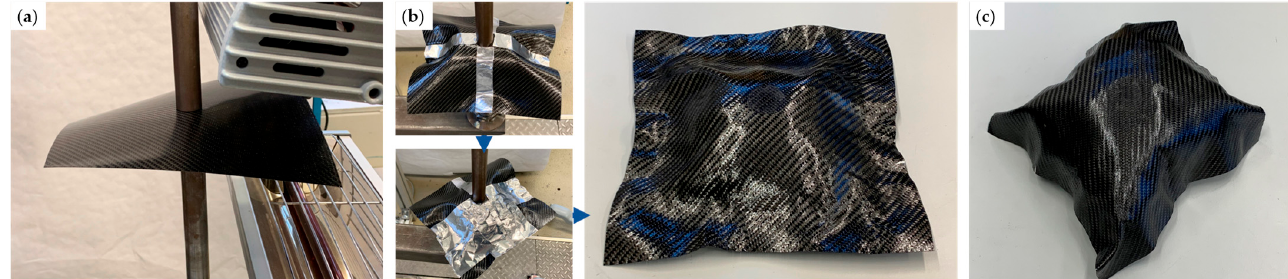
Figure 21. ( a ) Organo sheet centrally clamped between two poles and heated by infrared heaters; ( b ) Forming sequence and result of dielessly forming a hemispherical frustum; ( c ) Resulting die- lessly formed hemisphere. formed